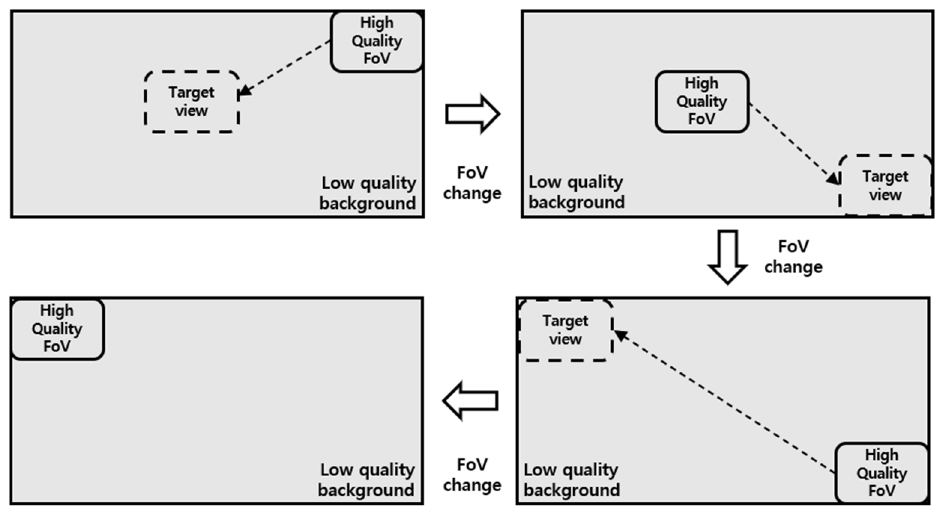
Figure 12. FoV transition event.